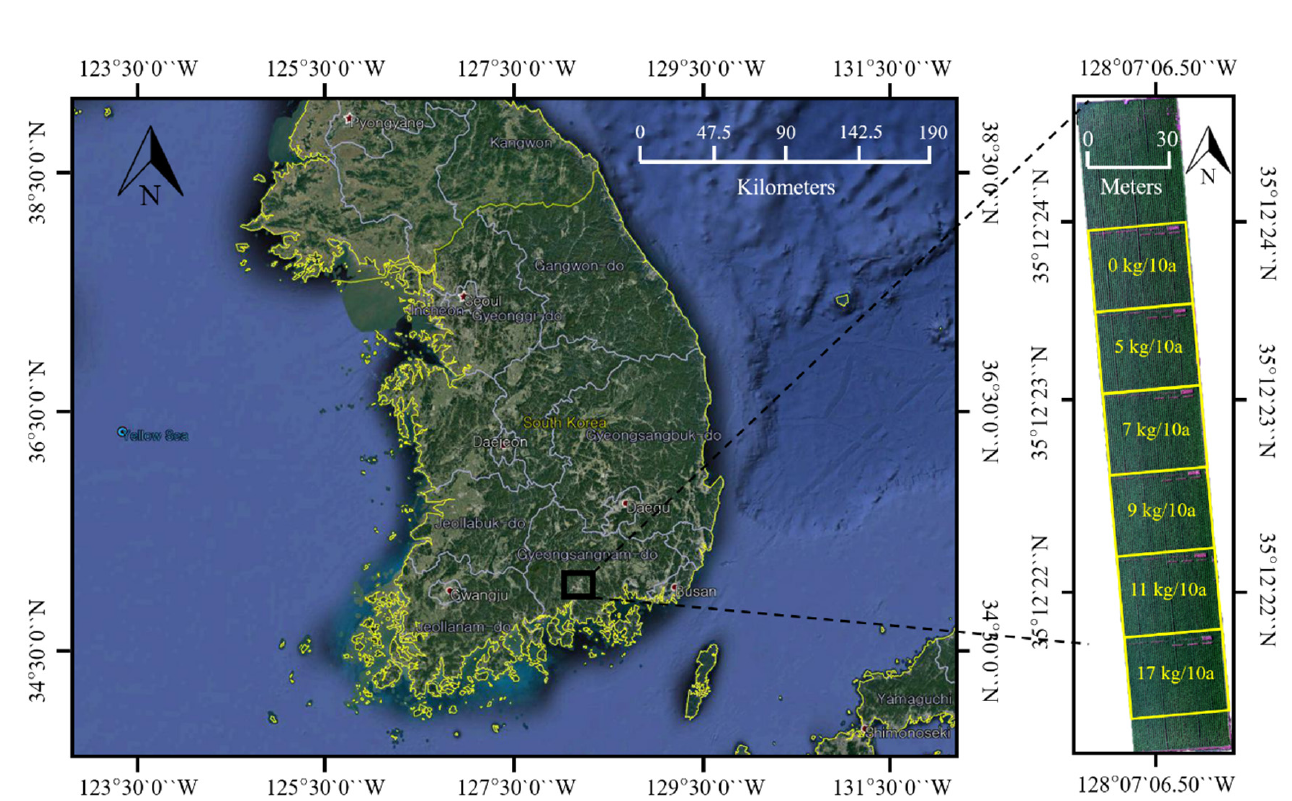
Figure 1. Location of rice field and layout of plots with different nitrogen fertilization treatments. Table 1. Rice-cultivation schedule and climatic conditions each year.